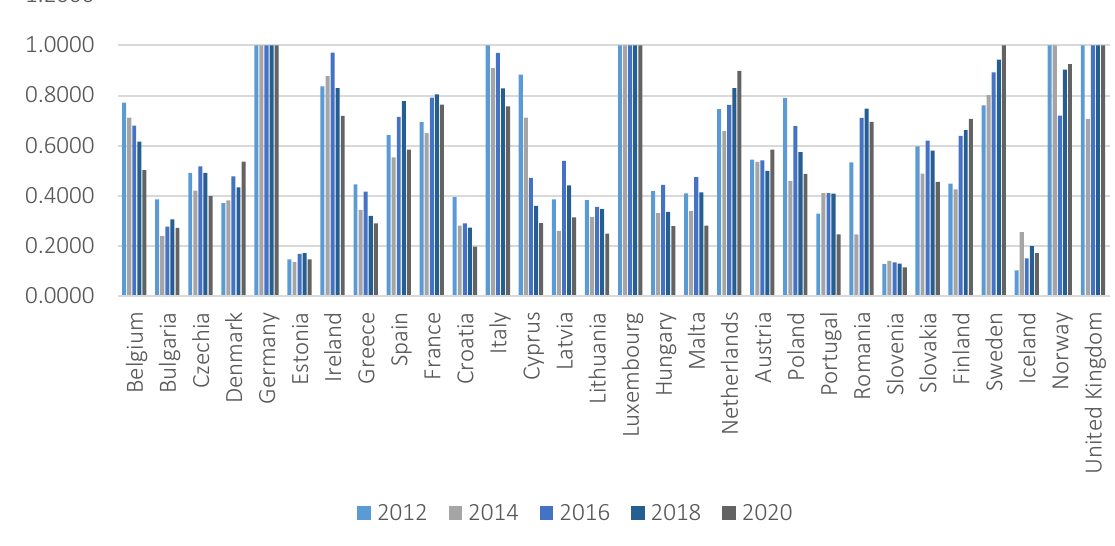
Figure 5. Estimated bi-annual values of TI, 2012–2020